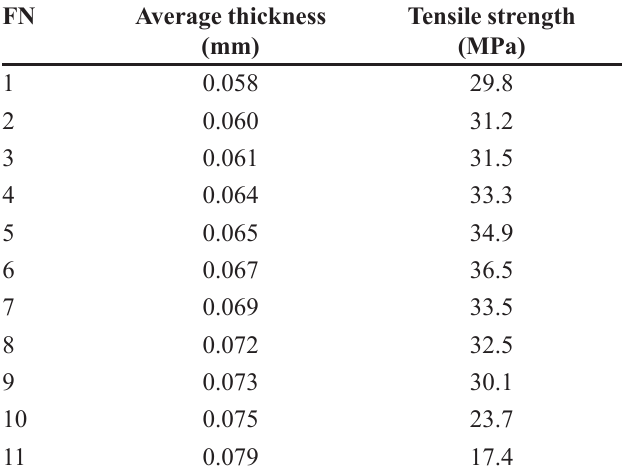
TABLE II - Physicochemical properties of the